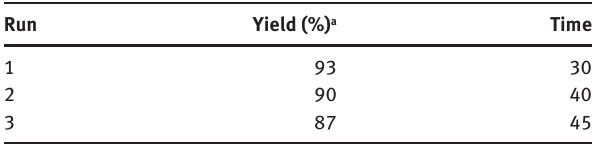
H nanoparticles. 3